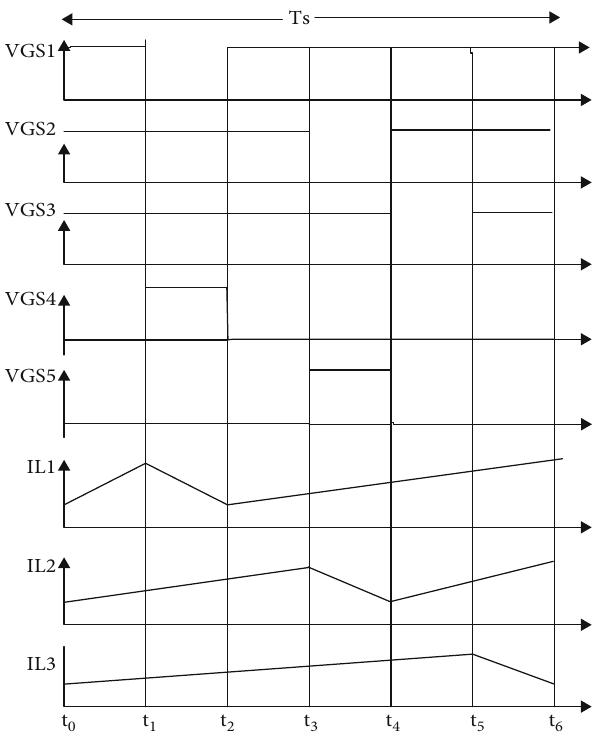
Figure 3: Major waveforms of the proposed